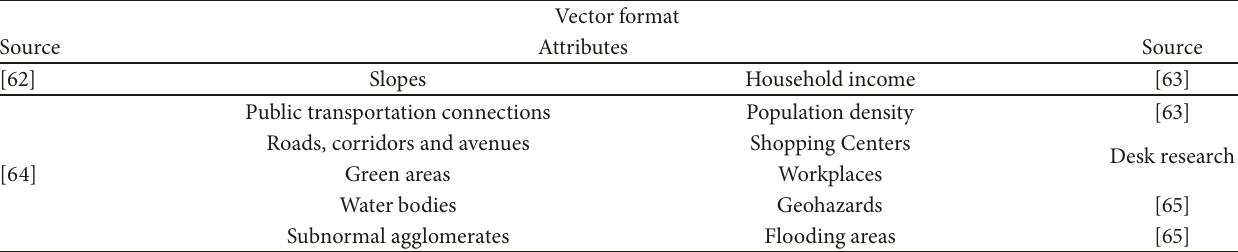
Table 3: Data source of the attributes in vector format.